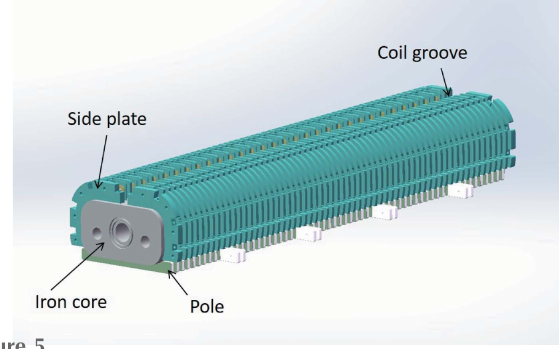
Figure 5 Structure of the SCU